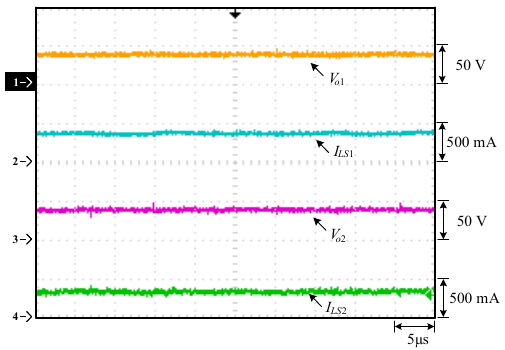
Figure 16. Waveforms at rated load: (1) v gs 1 ; (2) v gs 2 ; (3) V C 1 ; (4) i C 1 .